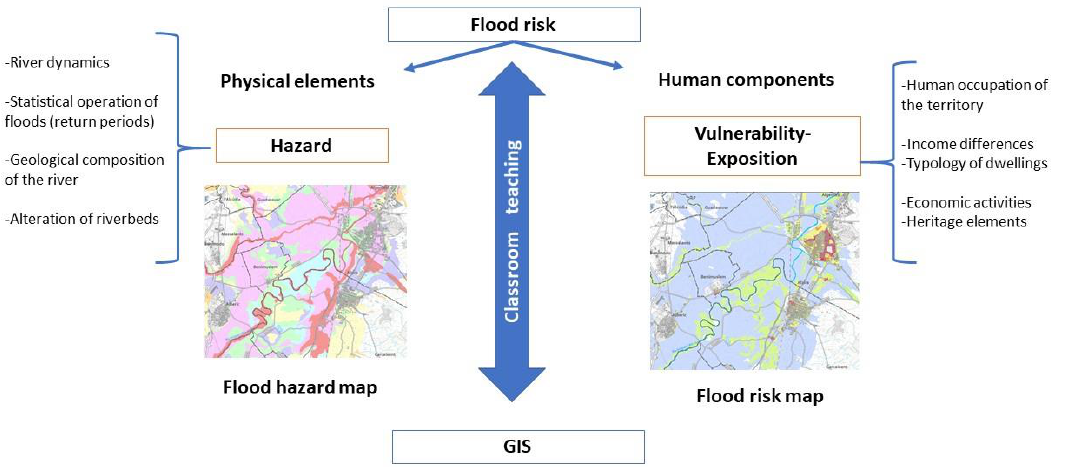
Figure 1. Physical and human factors that intervene in flood risk. Source: own elaboration.